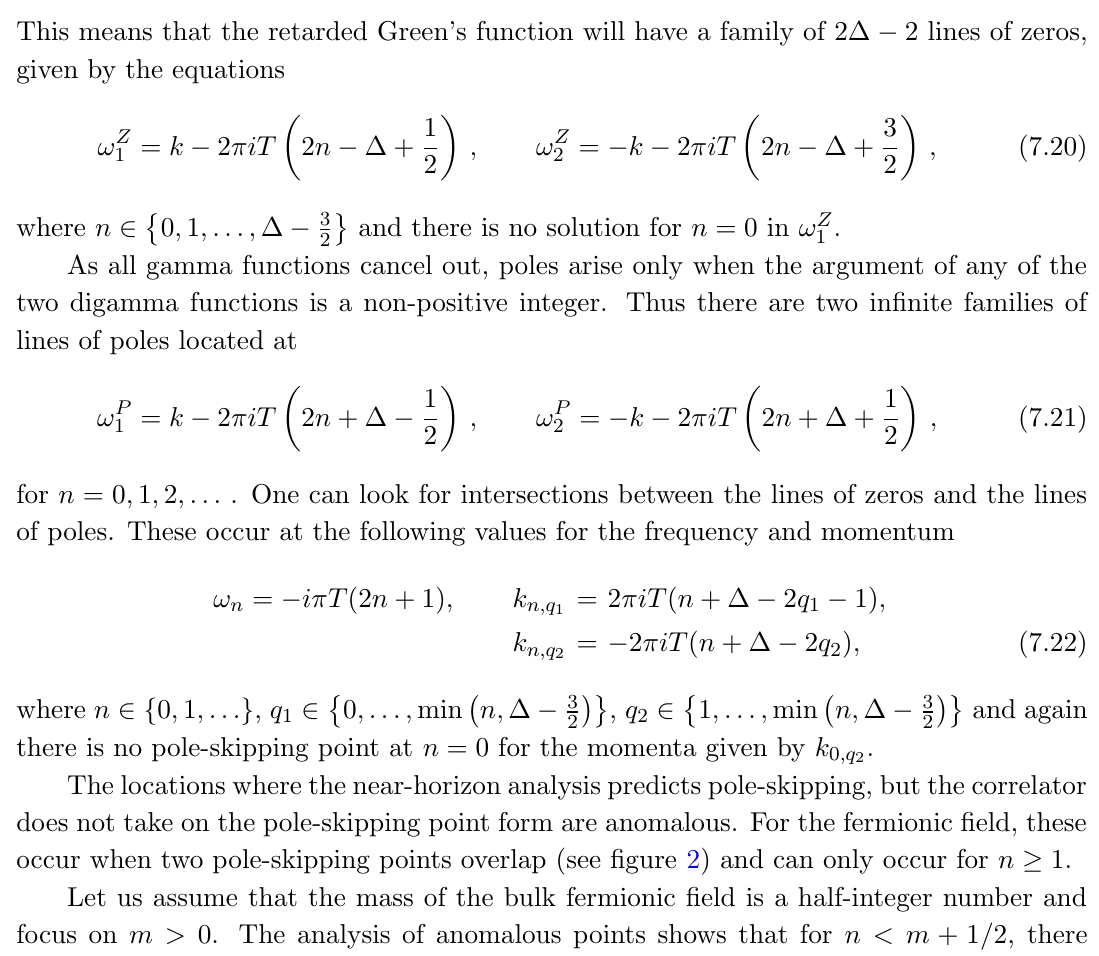
Figure 2 . Pole-skipping points as predicted from the near-horizon analysis for half-integer mass values. The left plot are the locations for m = 1 and the right plot contains the locations for 2 m = 3 . The gray points correspond to the momentum written with a positive sign in and the 2 hollow points correspond to the momenta with a negative sign as written in (7.12). We see that at half-integer values of the mass, some of the locations overlap (black circles with gray (cid:12)lling). These cases correspond to anomalous points and signal that a more thorough analysis of the boundary Green’s function is